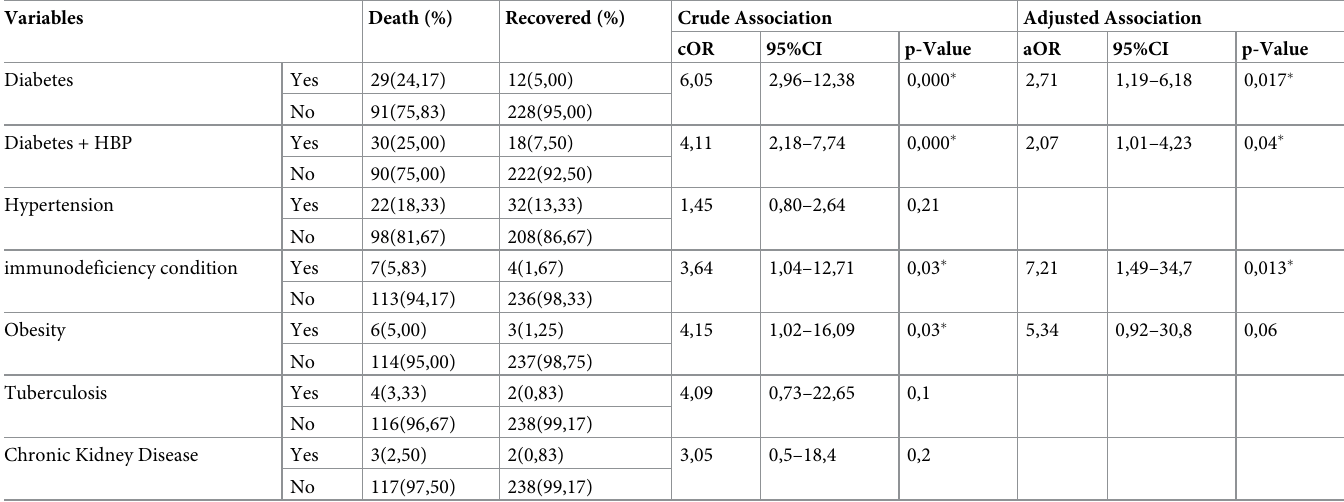
Table 3. Crude and adjusted association